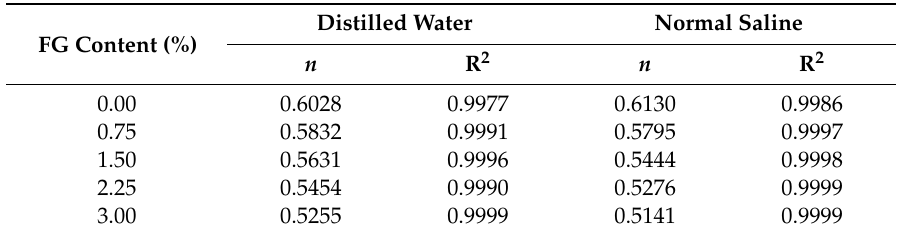
and normal saline (PVA content is